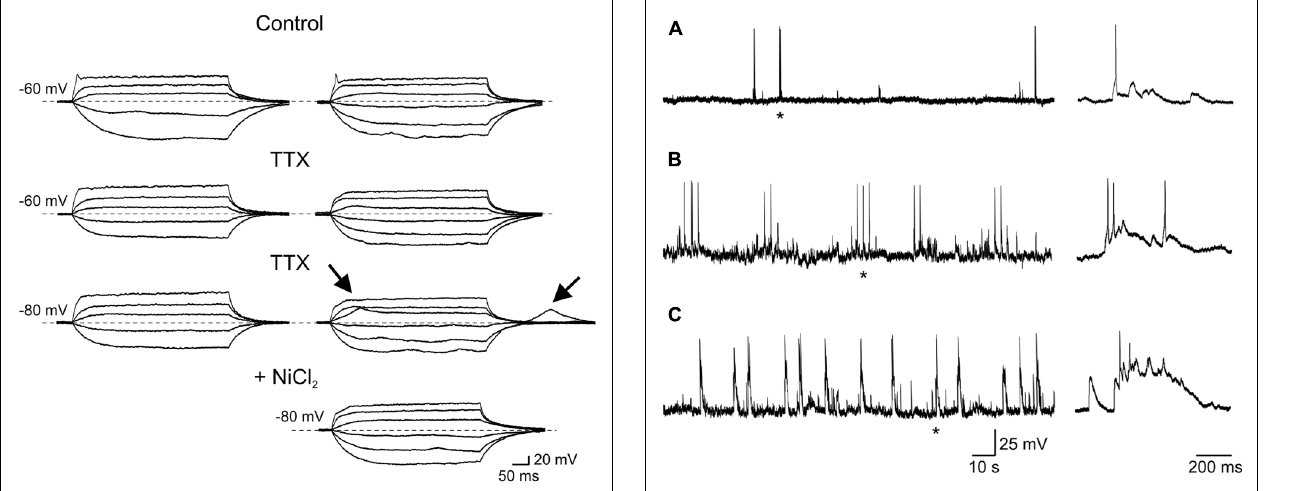
FIGURE 4 | Immature granule cells exhibit rudimentary sodium spikes and low threshold calcium spikes. Voltage responses obtained in two GCs (at P2) exhibiting sodium (right and left columns) and low threshold calcium currents (right). In control, both GCs exhibited small amplitude rudimentary spikes (at − 60 mV, upper traces) that were blocked byTTX (1 μ M). In the presence ofTTX, depolarizing current pulses from − 80 mV evoked only in the cell to the right a low threshold calcium spike.This was also present upon membrane re-polarization following an hyperpolarizing current step. Low threshold calcium spikes (marked by arrows) were blocked by nickel (100 μ M, lower trace on the right).